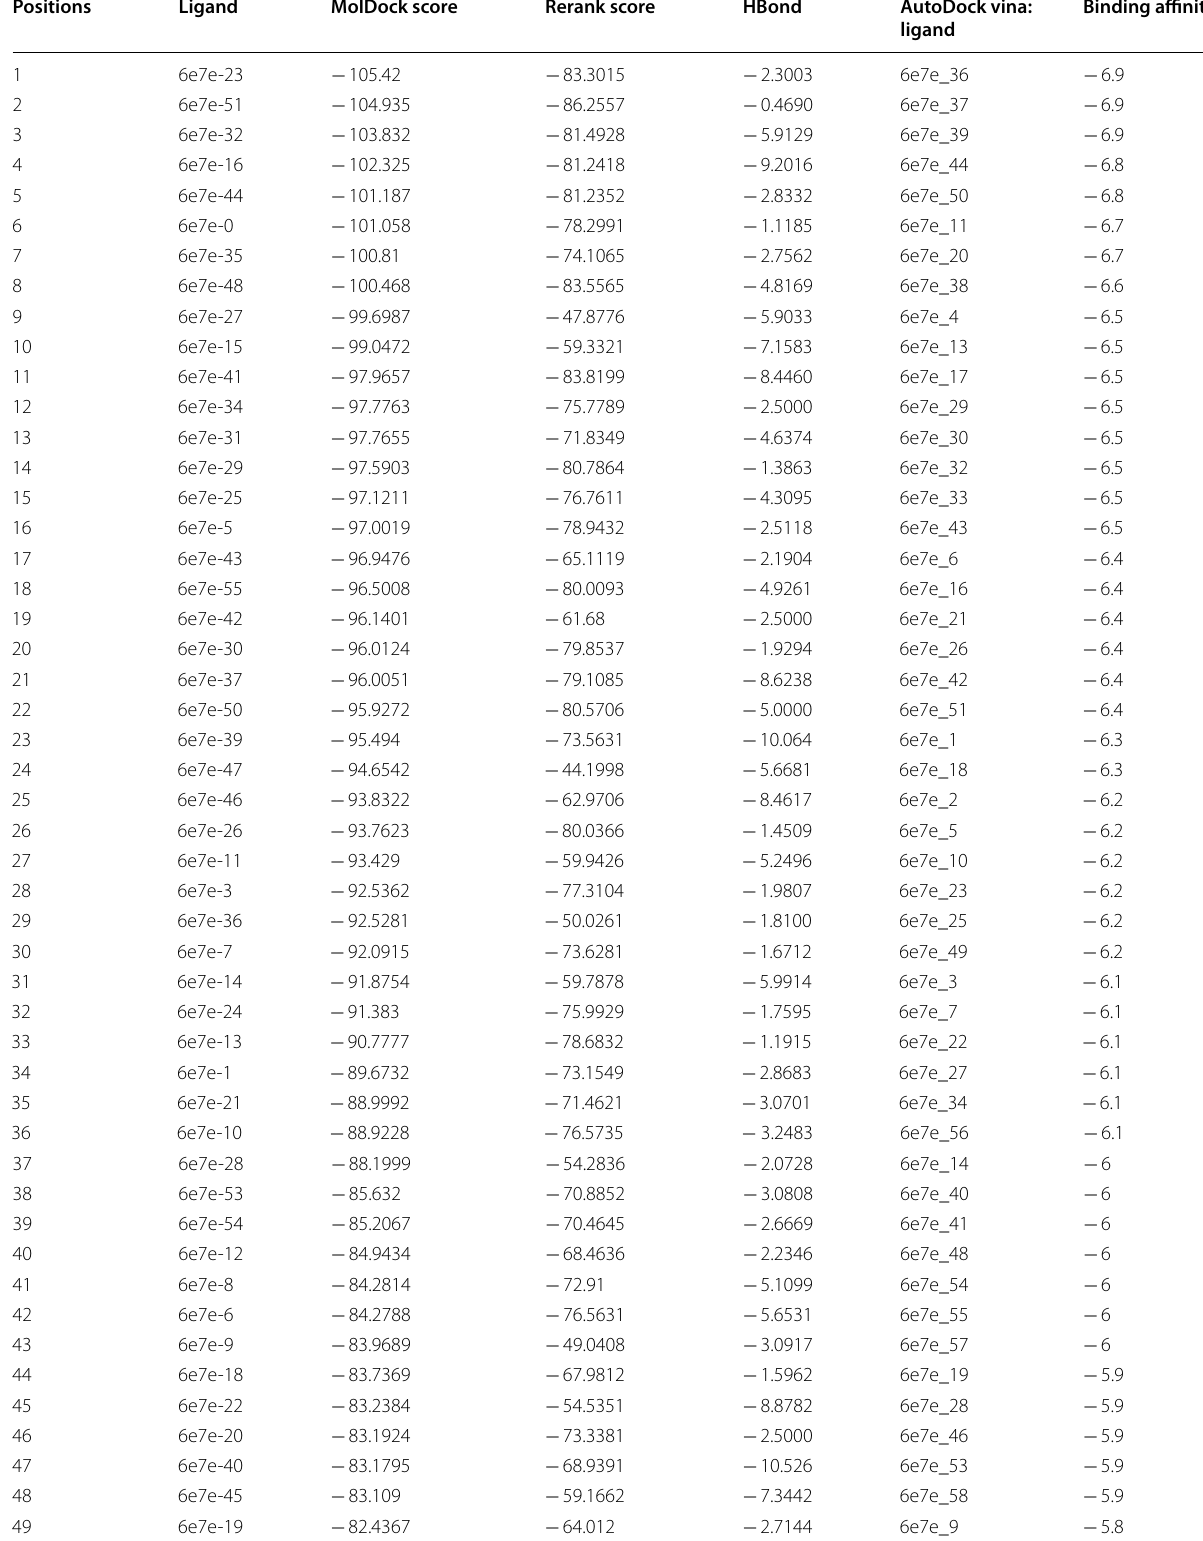
Table 5 The MolDock scores and AutoDock Vina binding affinity of the docked compounds Positions Ligand MolDock score Rerank score HBond AutoDock vina: